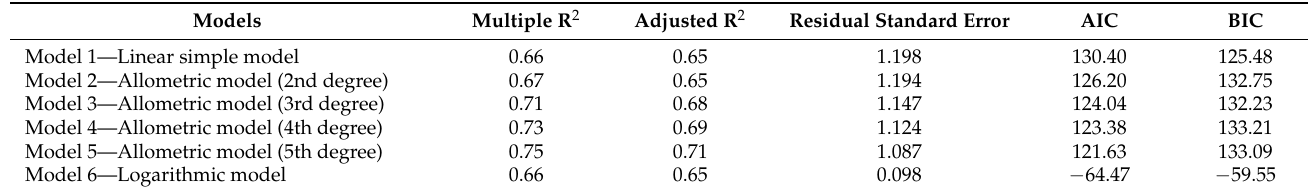
Table 2. Models N ◦ 1, 2, 3, 4, 5, and 6, with their evaluation criteria. Models Model 1—Linear simple